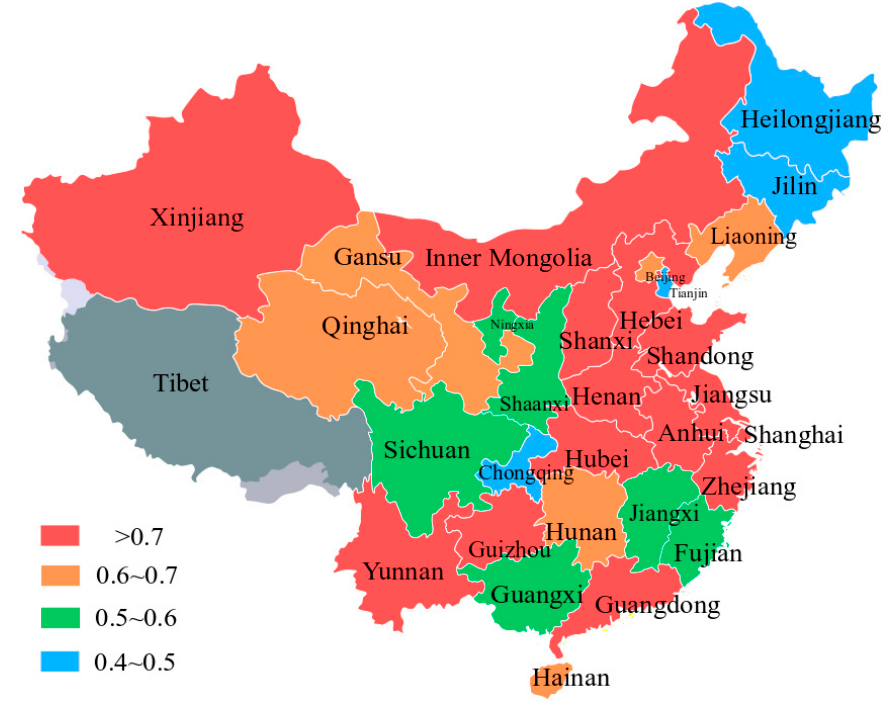
Figure 6. Comprehensive provincial PV power generation efficiency of the 30 regions in mainland China. Table 7. Mean value and rankings of six major regions.